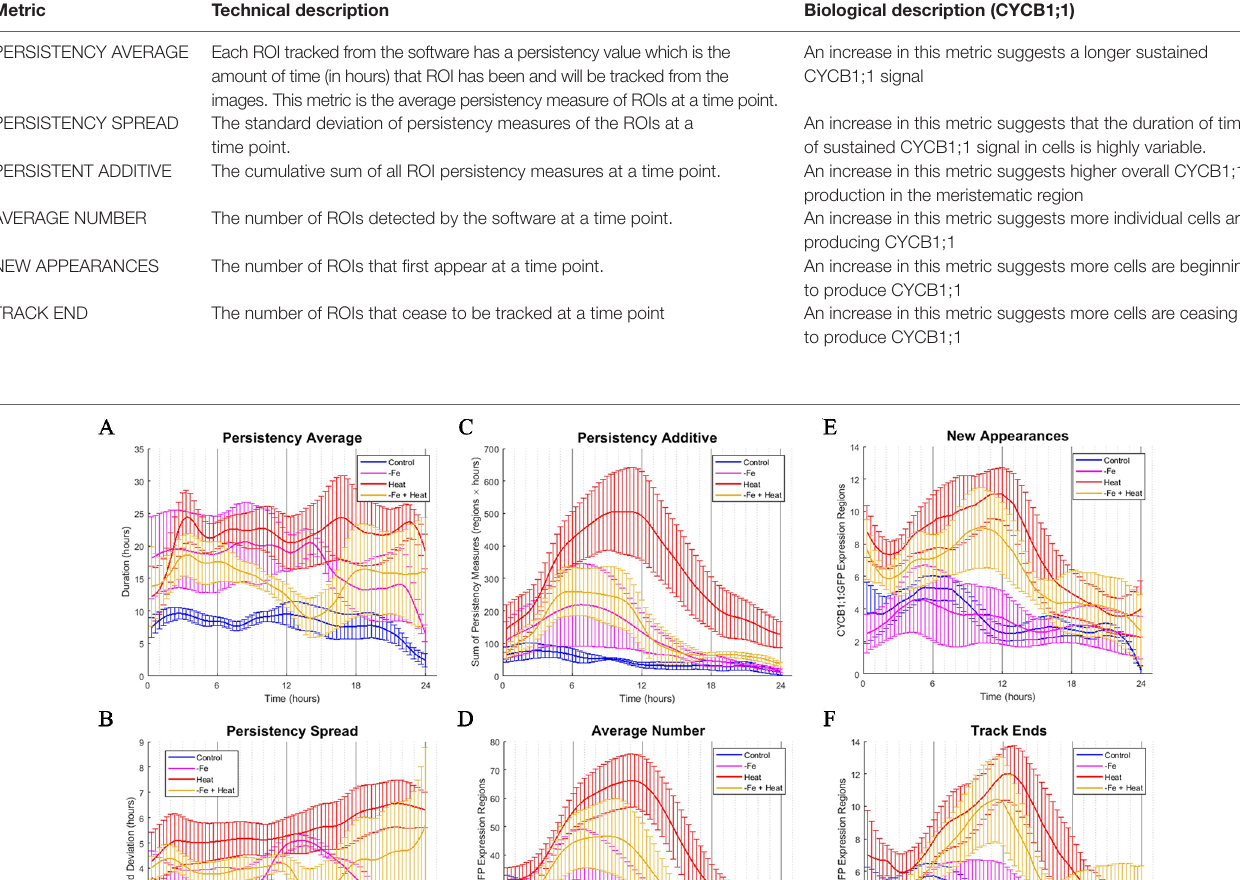
Frontiers in Plant Science |